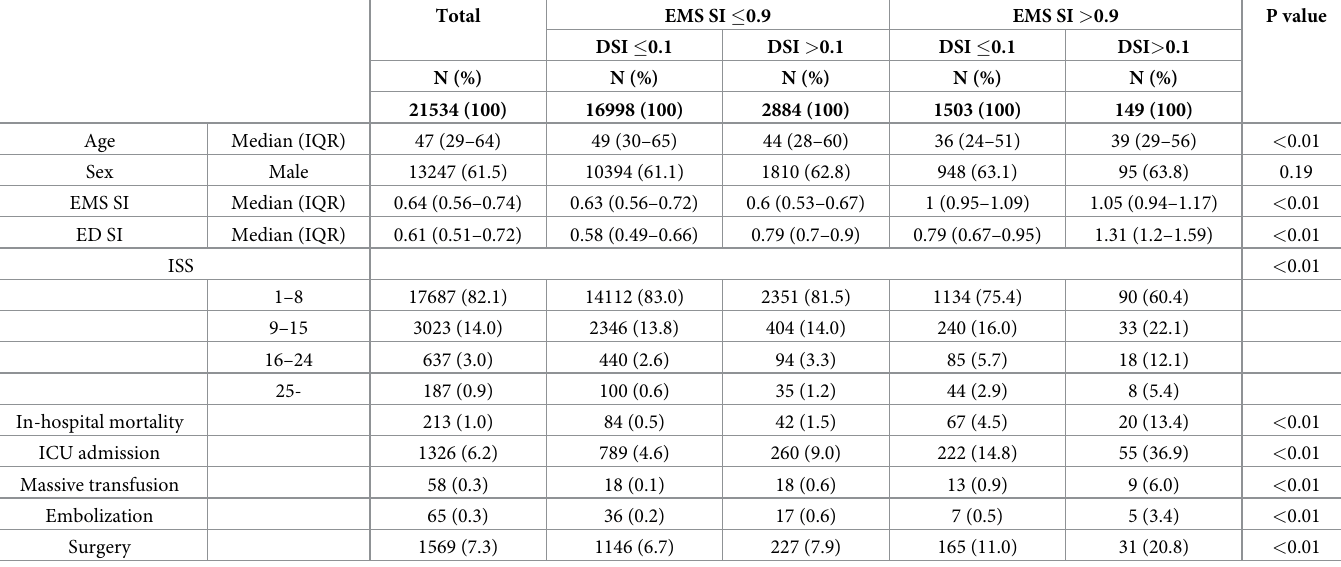
Table 4. Association between exposure groups and outcomes according to prehospital shock index in multivariate logistic regression